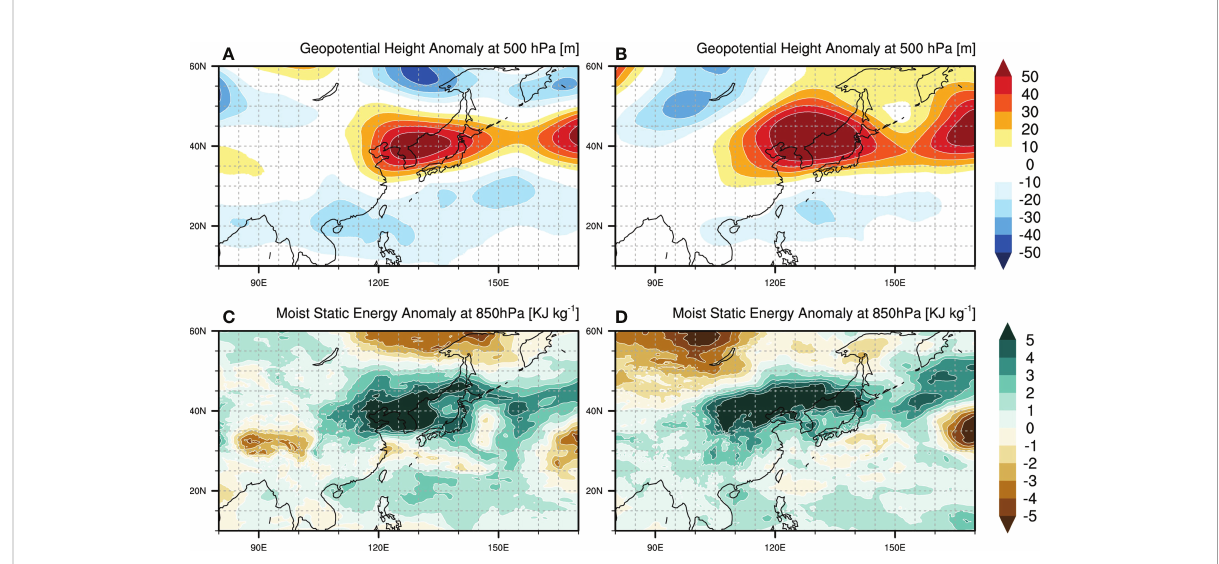
FIGURE 2 Horizontal distribution of geopotential height anomalies at 500 hPa (A, B) ; m and moist static-energy anomalies at 850 hPa (C, D) ; KJ kg − 1 in July 1994 (left) and 2018 (right), respectively, in East Asia (10 – 60° N, 80 – 170° E).